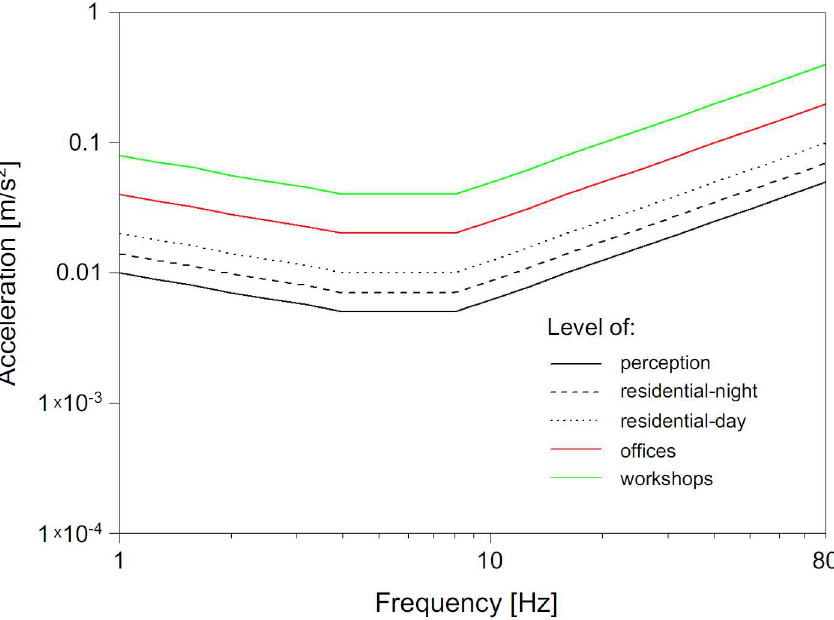
Figure 7. Perception level for vertical RMS acceleration and its multiplication for various conditions according to international standards [50].